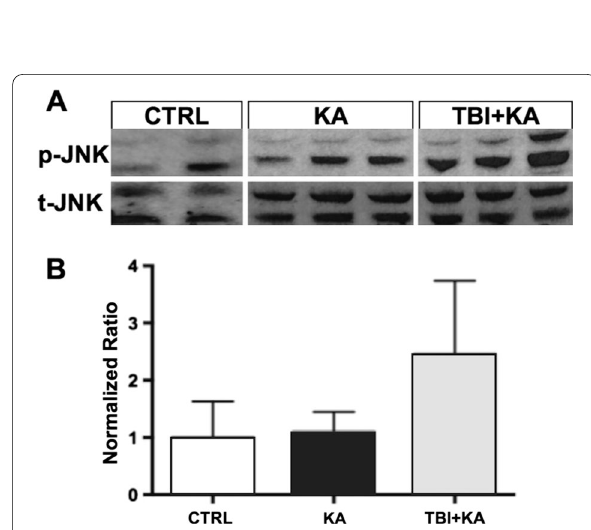
Fig. 7 Elevated JNK activity correlates with enhanced seizure susceptibility. a Western blot from control, kainic acid, and TBI acid. b Kainic acid alone did not increase the phosphorylation ratio but combined with TBI the ratio was increased, which can limit seizure